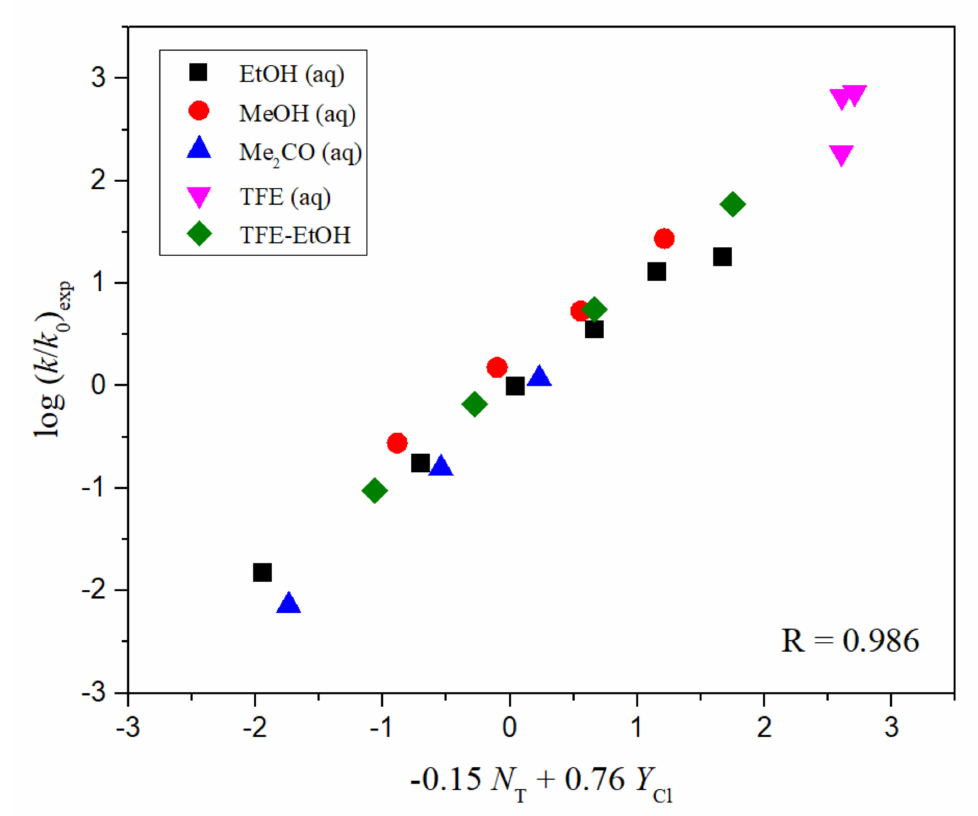
Figure 2. The plot of log ( k / k o ) exp for 1-adamantyl chlorothioformate ( 1 ) against − 0.15 N T + 0.76 Y Cl in all of the 20 solvents at 25.0 ◦ C. N T is the solvent nucleophilicity, Y Cl is the solvent ionizing power, R is correlation